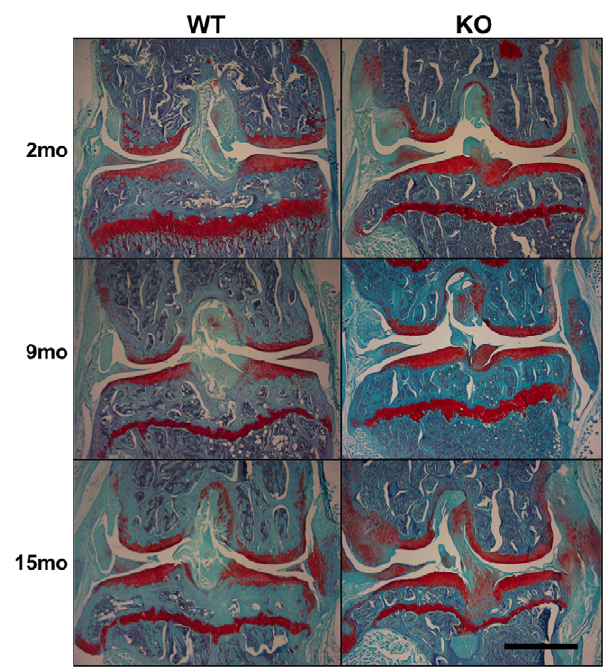
Figure 6. Histologic images revealed differences among wild- type and Col6a1 2 / 2 knees at 2, 9, and 15 months. Coronal tissue slices (7 m m thick) were stained with fast green for collagen (blue) and safranin-O for proteoglycans (proteoglycans), and Harris’ hematoxylin for nuclei (black). The left side is lateral while the right side is medial. The collagen VI null knees (right column) include a thick and proteoglycan-rich medial collateral ligament, increased chondrophyte formation on the lateral femur, larger trabeculae in both bones, and at 2 months a more confined growth-plate staining relative to the wild-type knees (left column). Scale bar=1 mm. WT= Col6a1 + / + ; KO= Col6a1 2 / 2